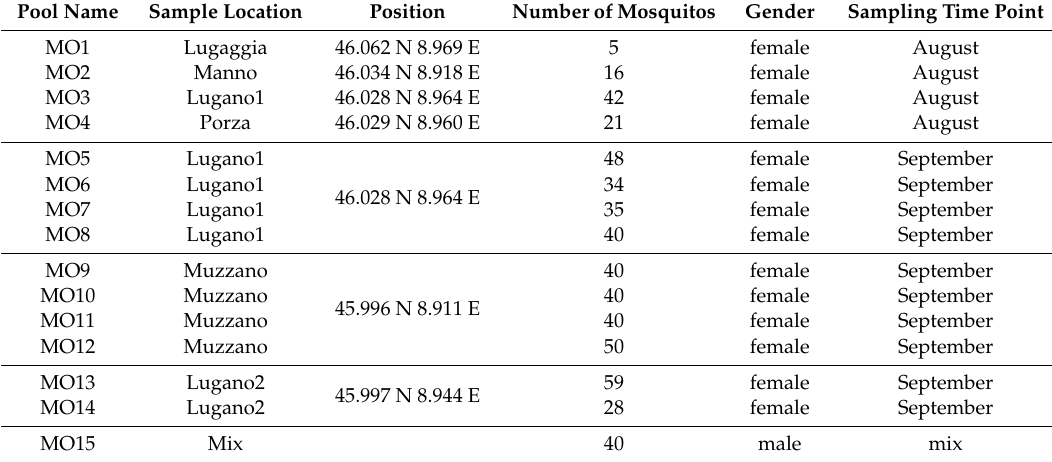
Table 1. Summary of the mosquito samples used in this study. Male mosquitos were collected at all locations and during the whole sampling